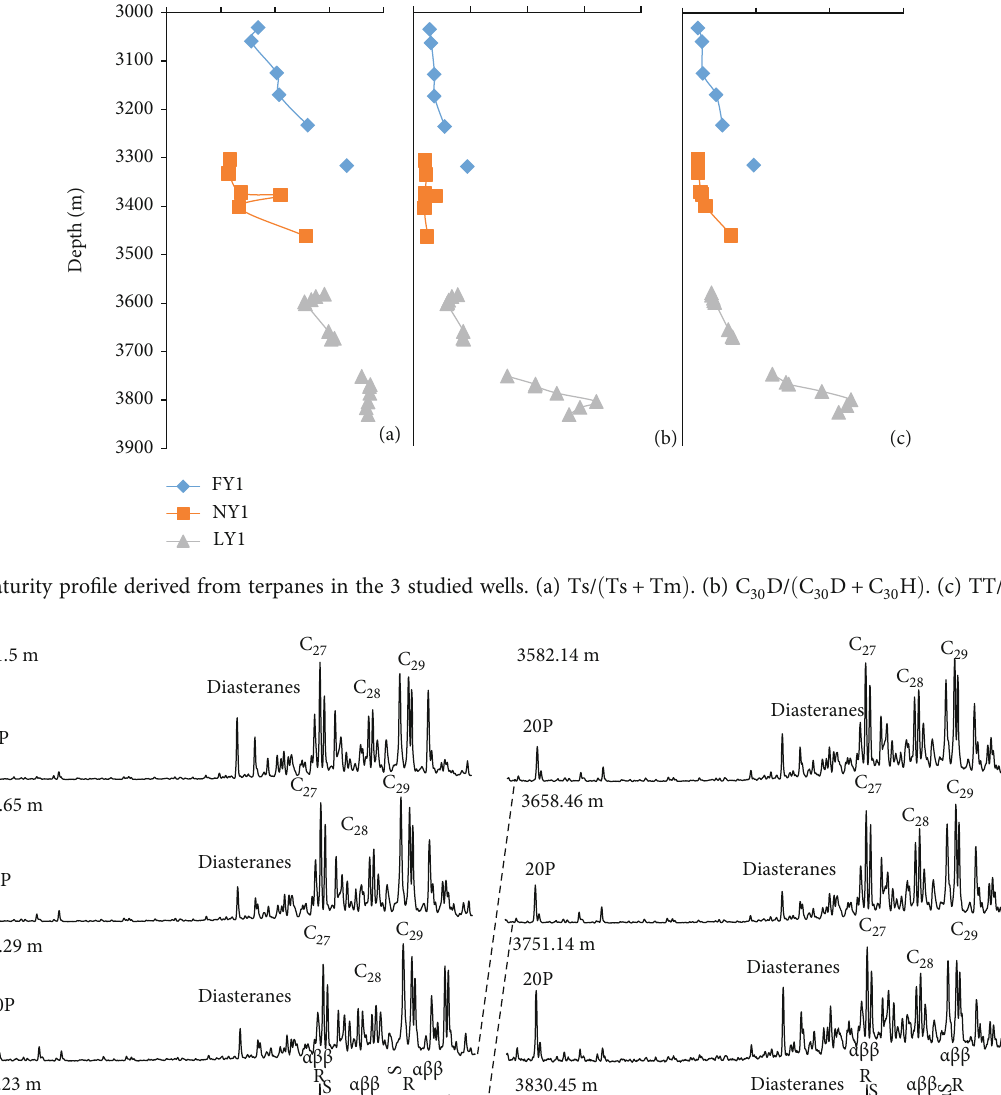
Figure 5: Mass chromatograms of m/z = 217 of the saturated hydrocarbon fraction showing the typical distribution of steranes with increasing burial depth in wells FY1 and LY1. 20-21P: C 5 α (H),14 β (H),21 β (H),20R; αββ S: 5 α (H),14 β (H),21 β (H),20S; ααα R: 5 α (H),14 α (H),21 α